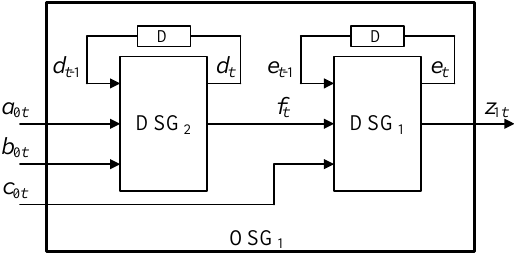
Figure 8. The output sequence generator 1.